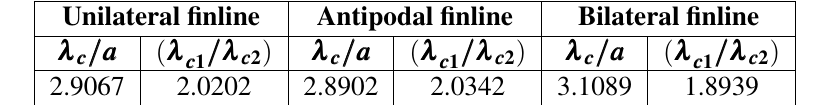
/ λ c 2 ) in three kinds of c 1